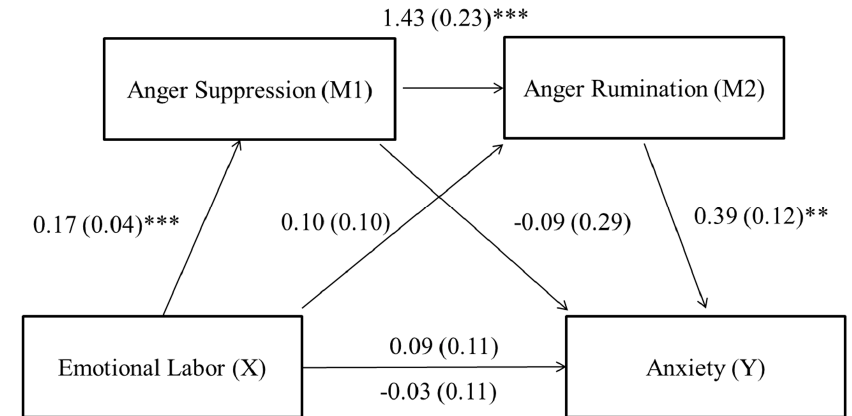
Figure 2. Sequential mediation model for emotional labor and anxiety via anger suppression and anger rumination. The unstandardized path coefficients and SE are indicated above. The coefficient appearing above the line connecting emotional labor and anxiety represents the total effect and the coefficient below the line represents the direct effect. ** p < 0.01, *** p < 0.001.